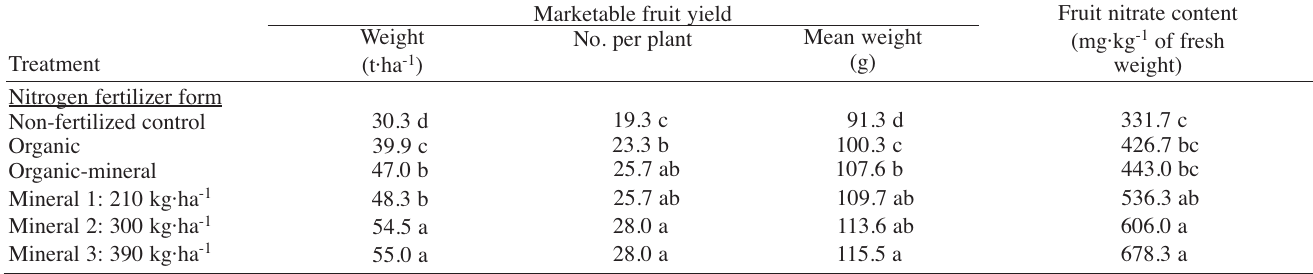
Table 7 - Zucchini under tunnel: yield results and fruit nitrate content in the winter-spring cycle as a function of nitrogen fertilizer form. Fondi (Latina, Italy), 2003-2004